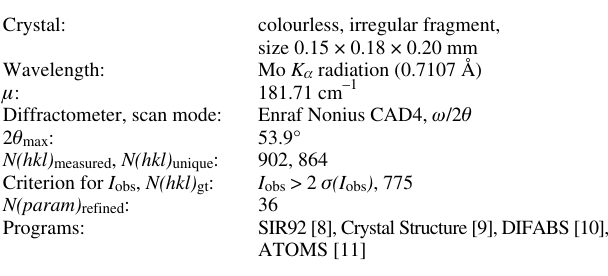
Table 1. Data collection and handling.